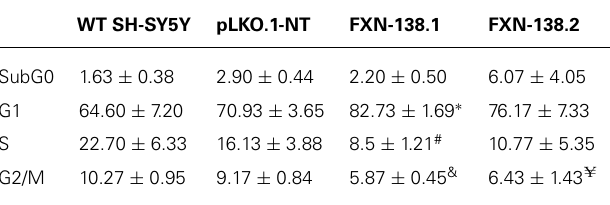
Table 1 | Distribution of cell cycle phases (%) of wild-type (WT) SH-SY5Y, pLKO.1-NT, FXN-138.1, and FXN-138.2 cells.